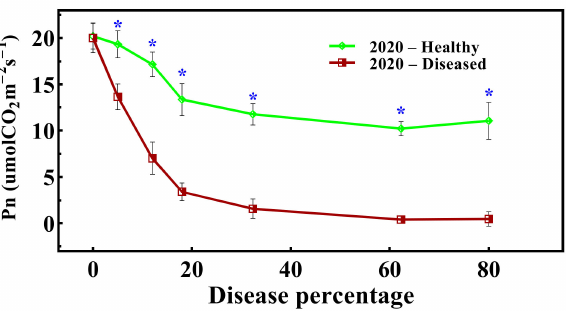
Figure 4. Dynamics of wheat canopy net photosynthesis variation at different disease severity percentages after inoculation in the wheat growing season of 2020, where blue asterisks mark the statistical significance between healthy and diseased samples and error bars represent variations within